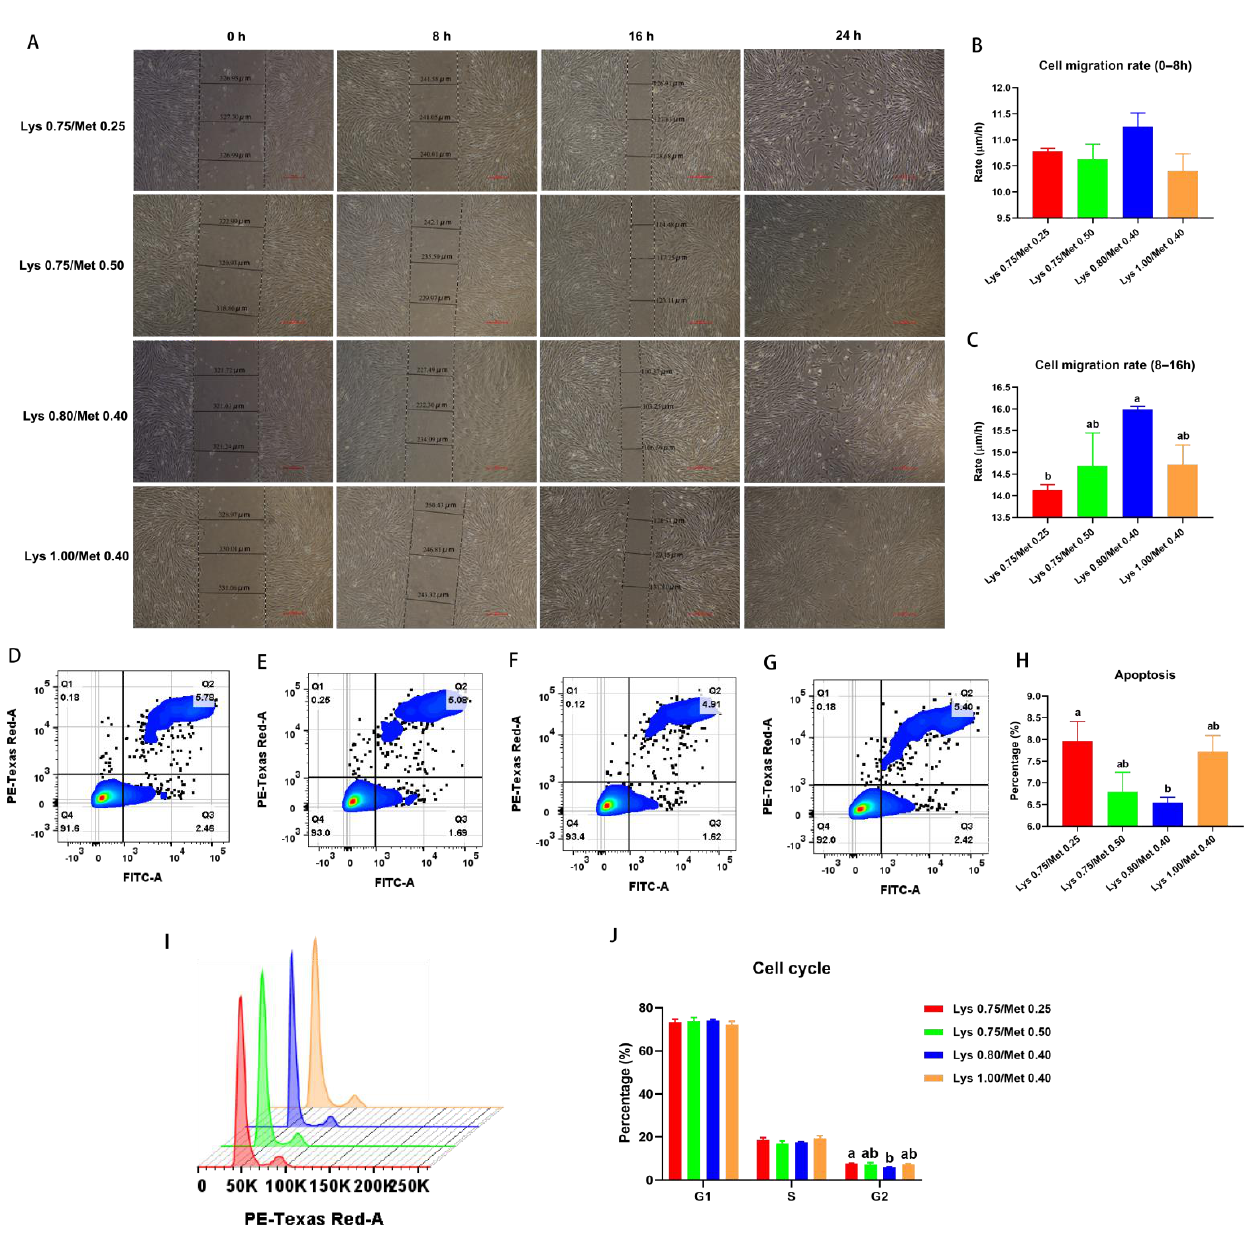
Figure 2. Effects of different dietary lysine and methionine composition on satellite cell migratory potential, division, and apoptosis in rabbits. ( A – C ) Cell migration assay. Image recording of cell migration ( A ), cell migration rate between 0 and 8 h ( B ), and cell migration rate between 8 and 16 h ( C ). ( D – H ) Cell apoptosis. ( D ) 0.75% Lys/0.25% Met composition group, ( E ) 0.75% Lys/0.50% Met composition group, ( F ) 0.80% Lys/0.40% Met composition group, ( G ) 1.00% Lys/0.40% Met composition group, and ( H ) statistics for cell apoptosis data. Cell cycle flow assay ( I ), cell cycle statistics ( J ). Data are expressed as means ± SEM ( n = 3). Comparisons between groups that contain only different lowercase letters indicate significant differences ( p < 0.05).